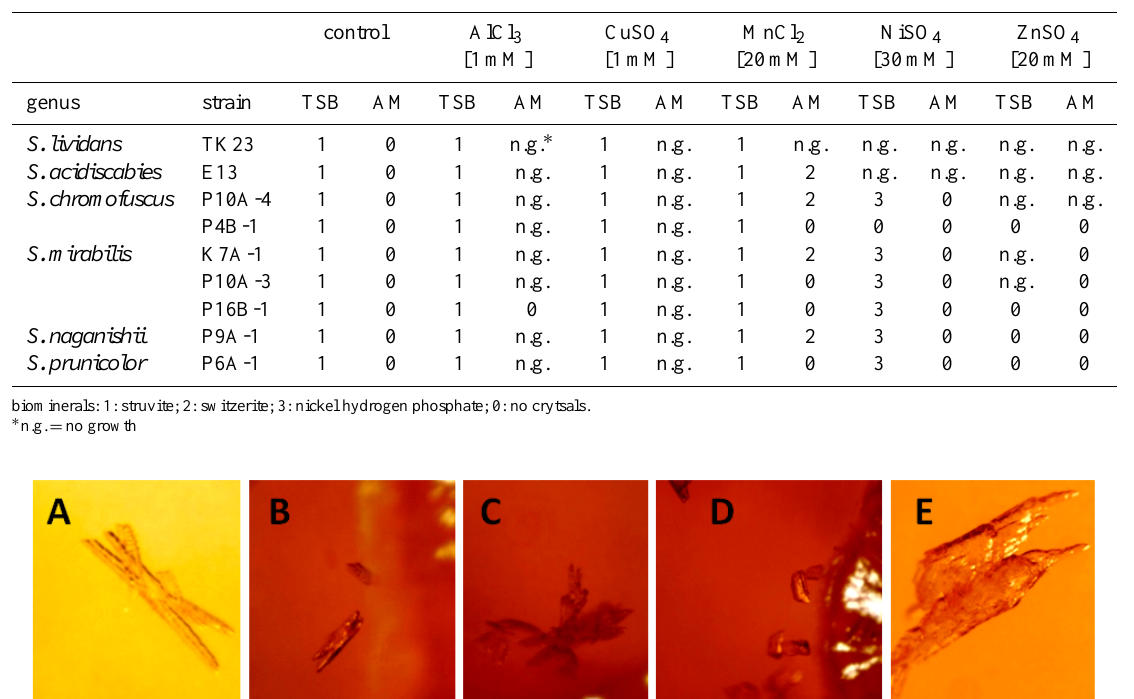
Table 1. Growth and biomineralization under artificial conditions. The strains were grown on plates containing the indicated heavy metal for 56 days ( n =